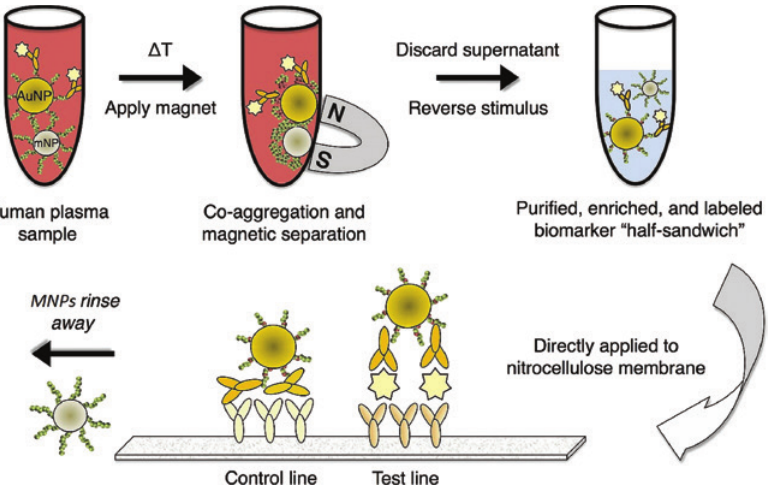
Figure 4: Separation and enrichment of malarial biomarker protein based on antibody-immobilized Au nanoparticles and thermo- responsive MNPs. Antibody-labeled Au nanoparticles with thermo-responsive polymer surface coating – poly(N-isopropylacrylamide) (pNIPAm) – were used to capture malarial biomarker protein in plasma. Subsequently, MNPs having pNIPAm coating and free pNIPAm were added to plasma following a temperature increase, which causes AuNPs/MNPs to aggregate, and they were separated by a magnet.